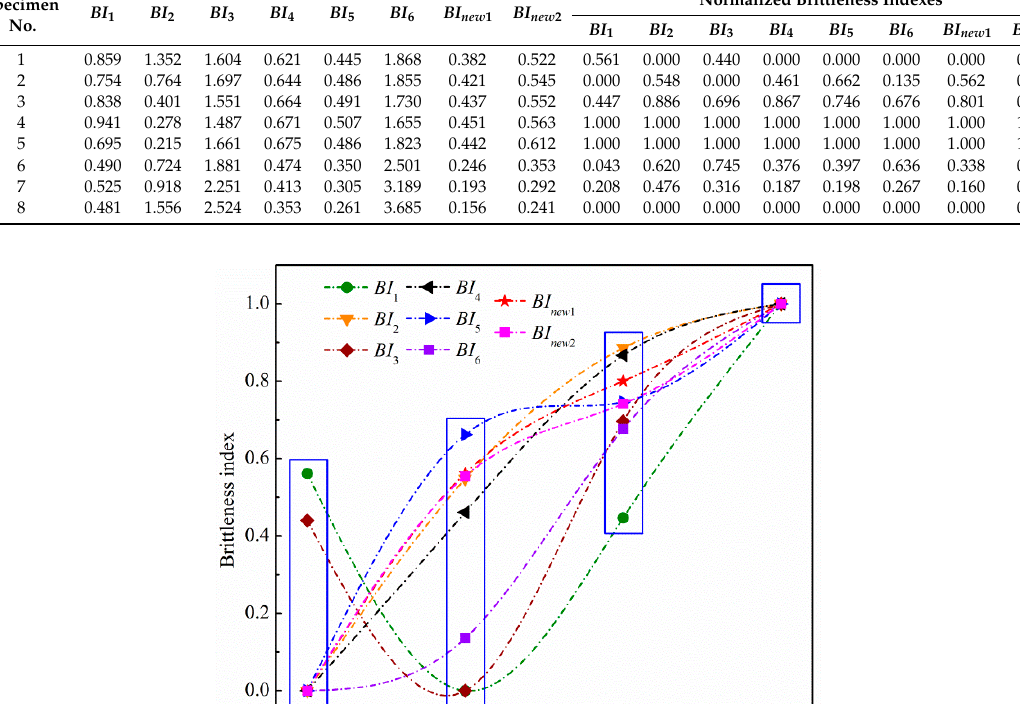
Figure 9. Normalized brittleness indexes of glutenite specimens under triaxial compression. We conclude that the results of the quantitative evaluation of glutenite brittleness using the new brittleness indexes 1 new BI and 2 new BI